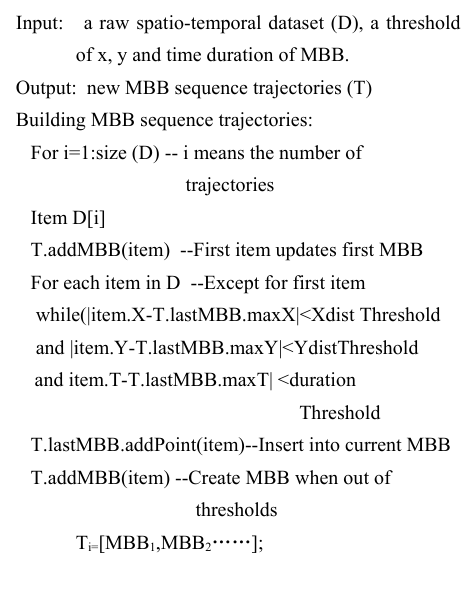
Fig.7. diagram of trajectory clustering